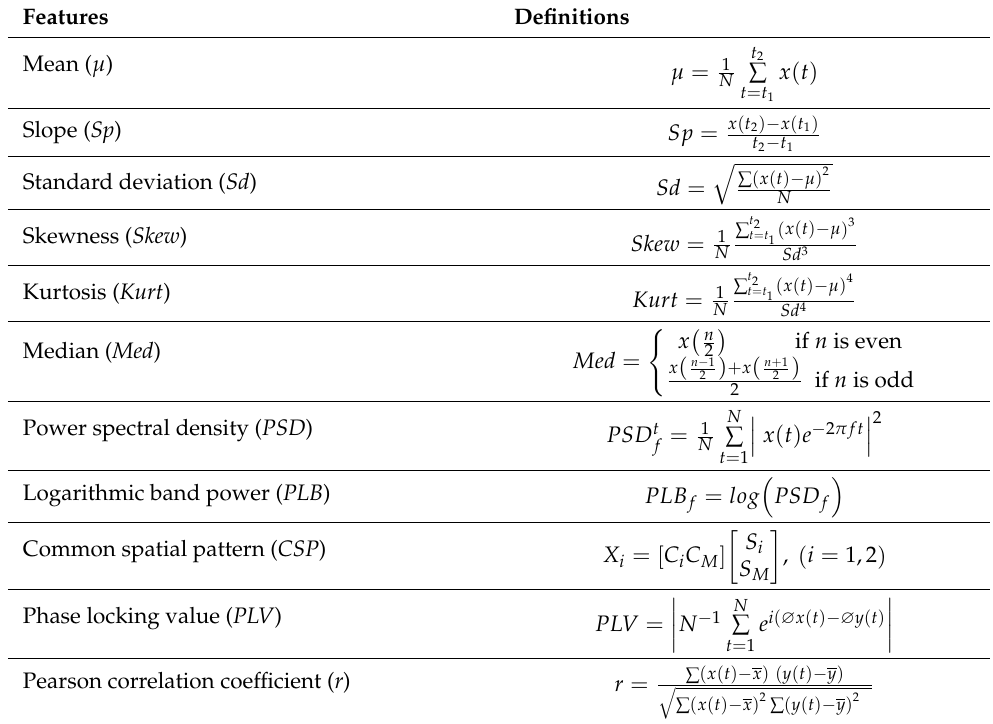
Table 3. Definition and calculation of EEG and fNIRS